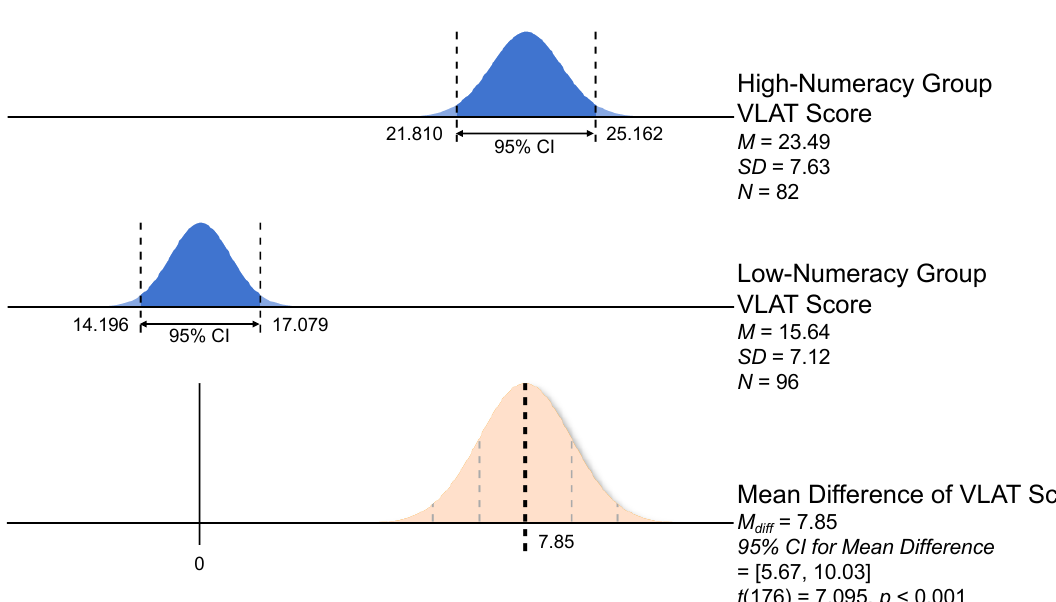
Figure 3. Difference in VLAT scores between high-numeracy user group and low-numeracy user